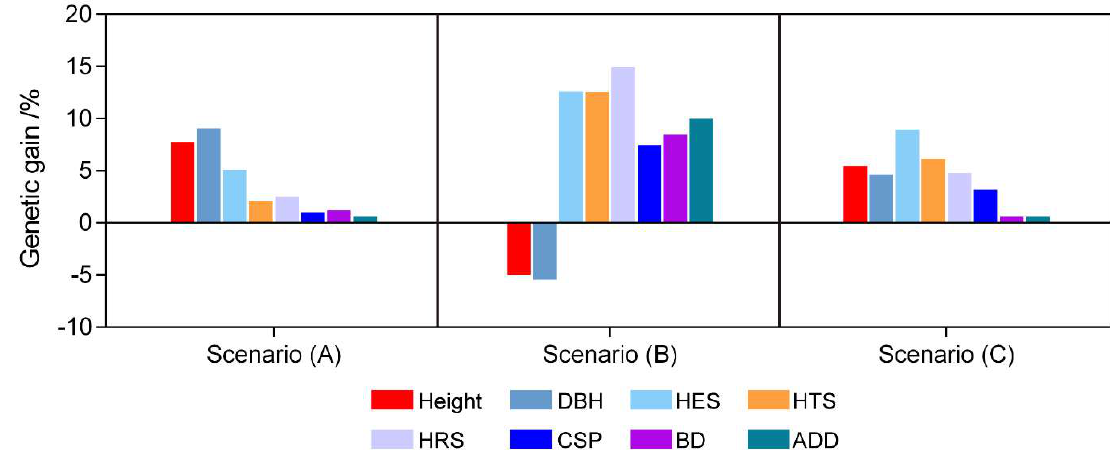
Figure 4. Genetic gains under different selection scenarios with a selection intensity of 20%.